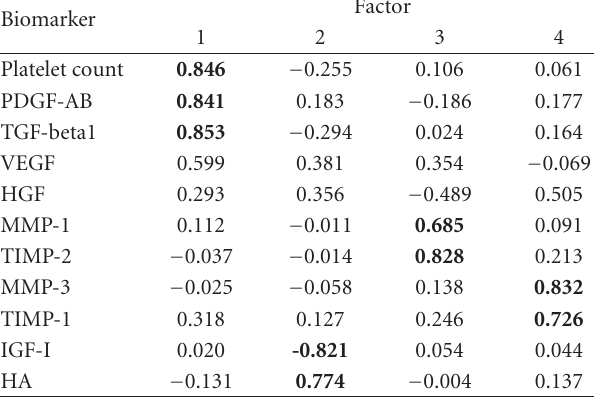
Table 2: Principal component analysis coe ffi cients of independent molecular marker factors in plasma from 63 patients with knee OA. Molecular markers were grouped into factors of related measures by principal component analysis using a Varimax rotation with Kaiser Normalization. Components with Eigen values > 1 were extracted. Primary components of each factor are shown in bold